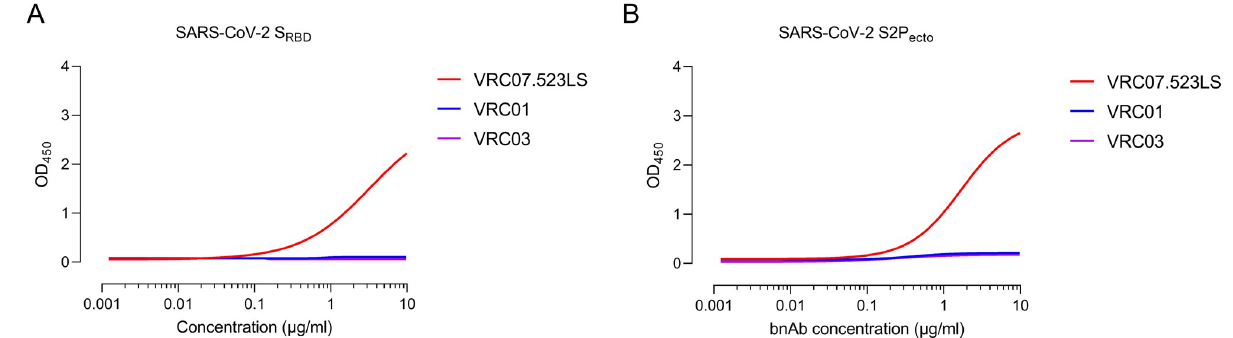
Fig 2. Somatically engineered VRC07.523LS cross-reacts with SARS-CoV-2. Cross-reactivity of anti-HIV-1 broadly neutralizing antibodies, VRC07.523LS, VRC01 and VRC03, targeting the CD4-binding site on HIV-1 Env. Cross-reactivity was assessed by ELISA using (a) SARS-CoV-2 RBD and (b) SARS-CoV-2 S2P ecto . OD 450 , optical density at 450 nm. OD 450 values are from a 12-point binding curve (range, 0.0048 to 10 μ g/ml).